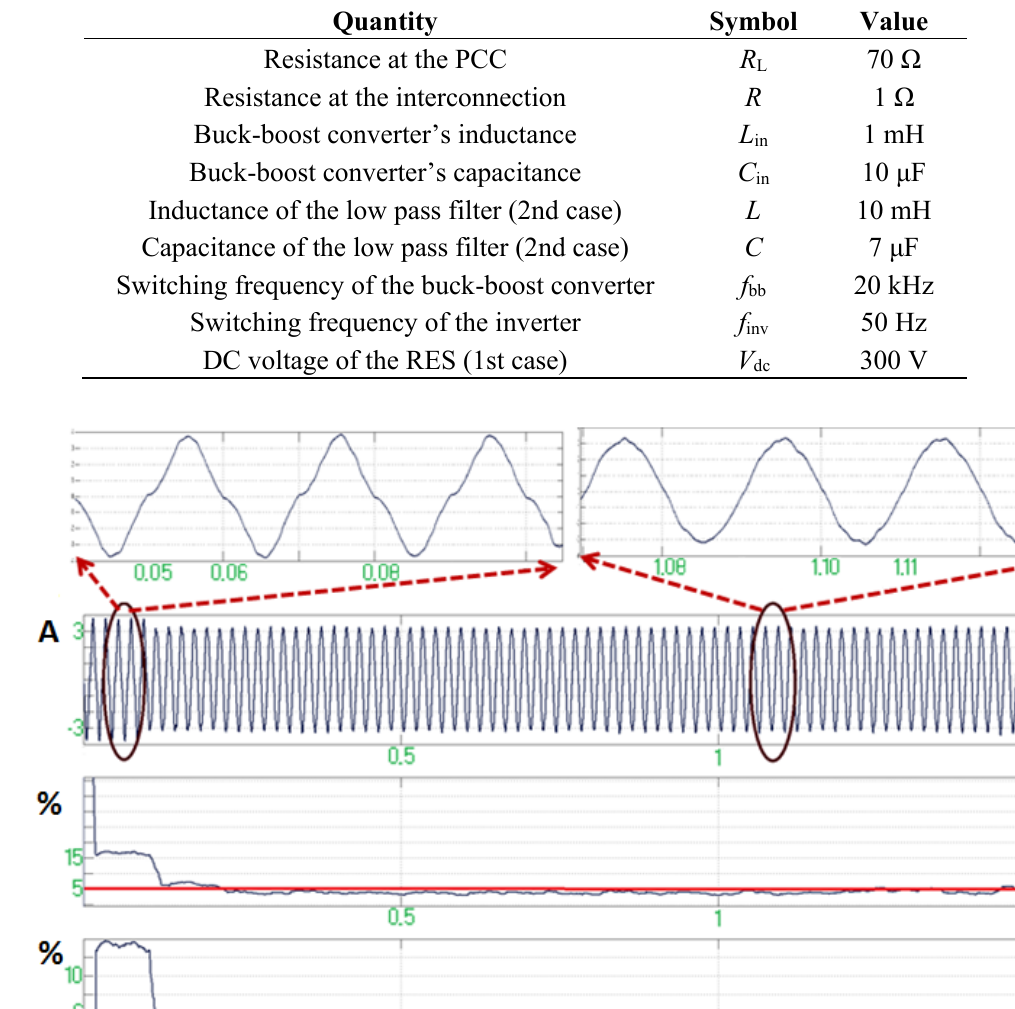
; ( b ) Grid’s current THD; ( c ) Grid’s current 3rd harmonic G